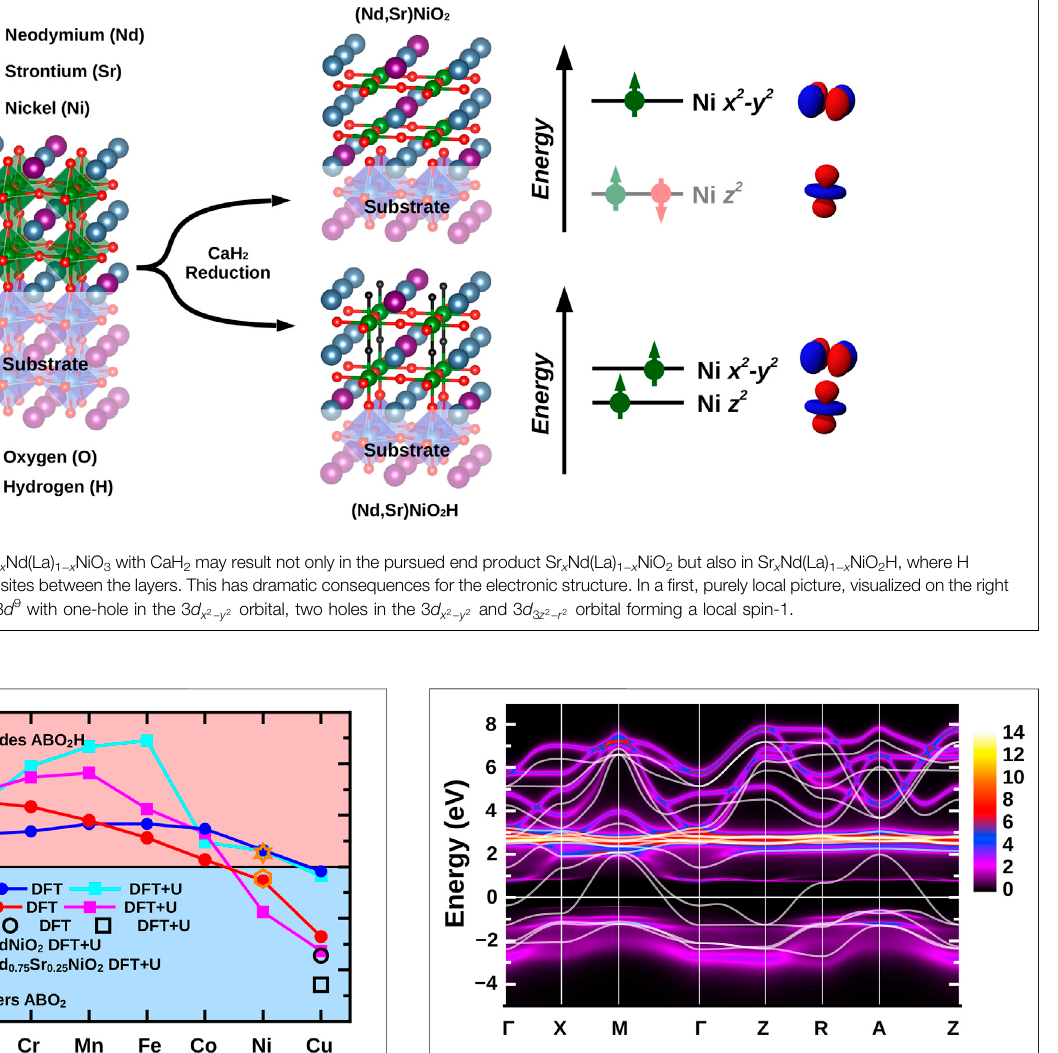
Figure 7 . The extra H takes away one more electron from the Ni sites. Hence, we have two holes on the Ni sites which in a local picture are distributed to two orbitals and form a spin-1, due to Hund ’ s exchange.